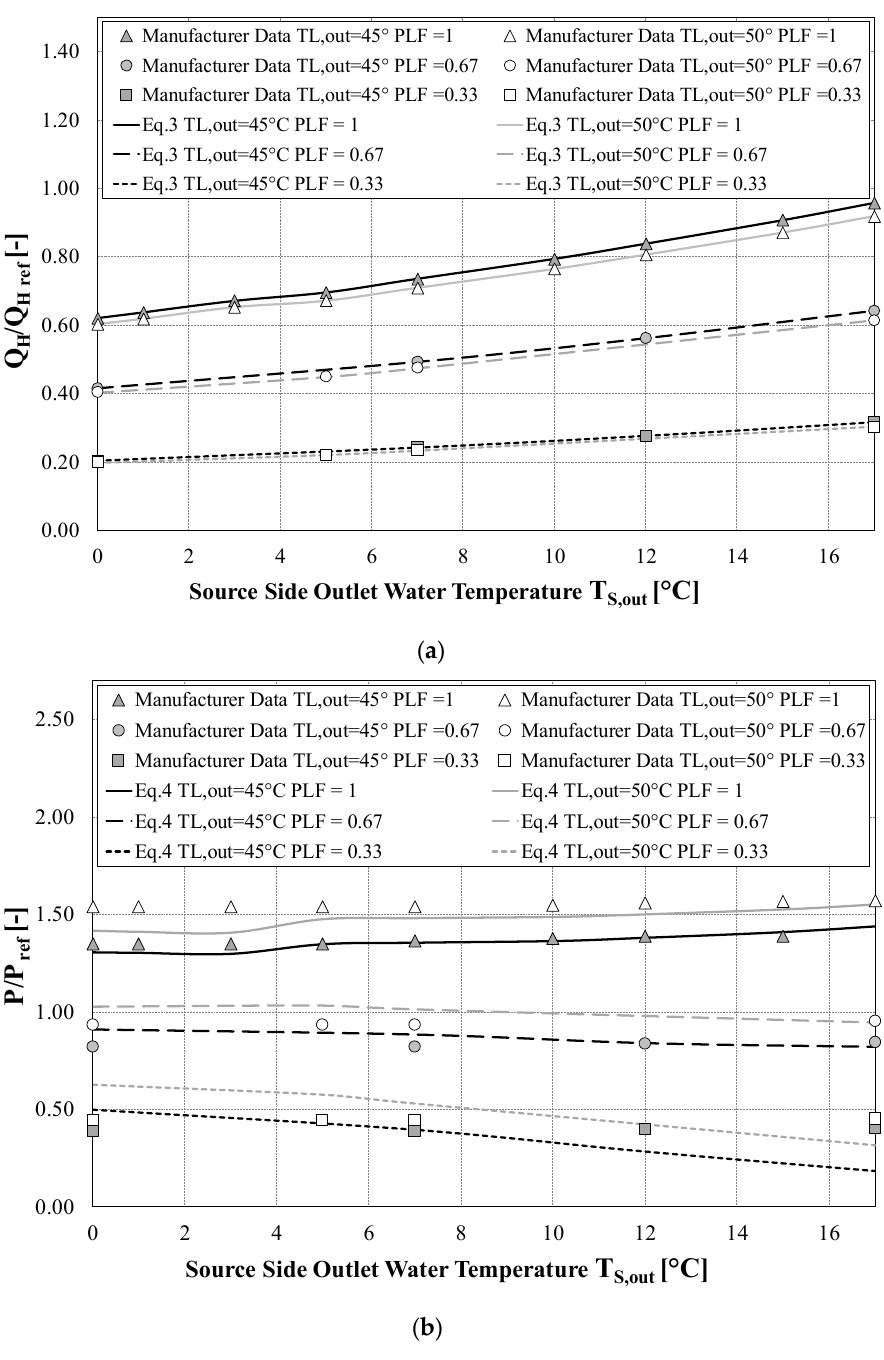
Figure 3. ( a ) Q H / Q H ref and ( b ) P / P ref comparison for heating mode.